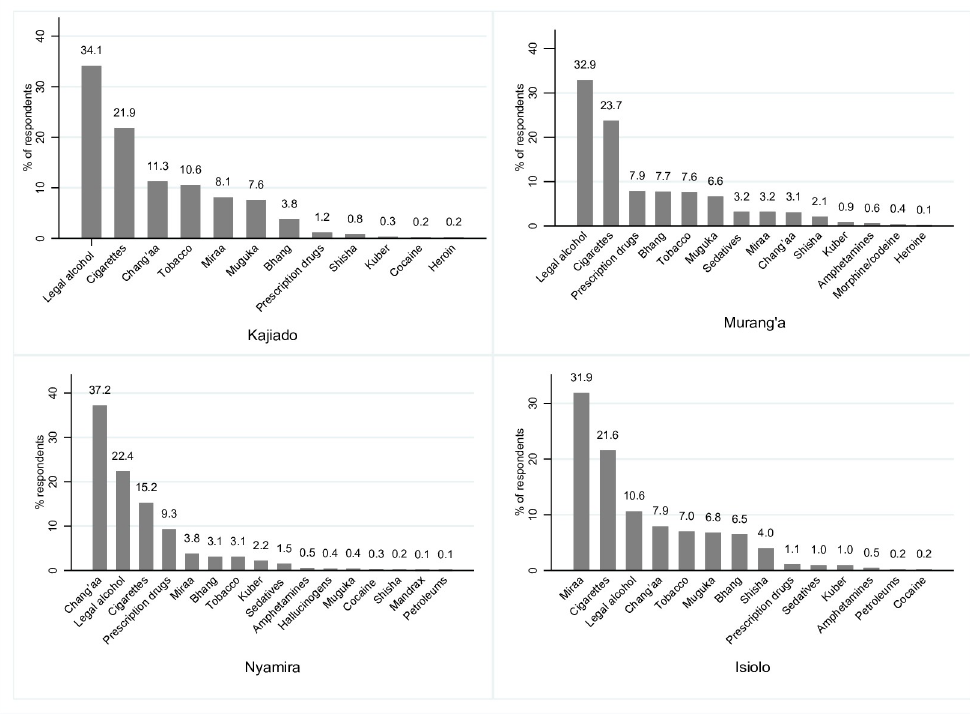
Fig 4. Types of drugs and substances abused by the study participants grouped by the surveyed